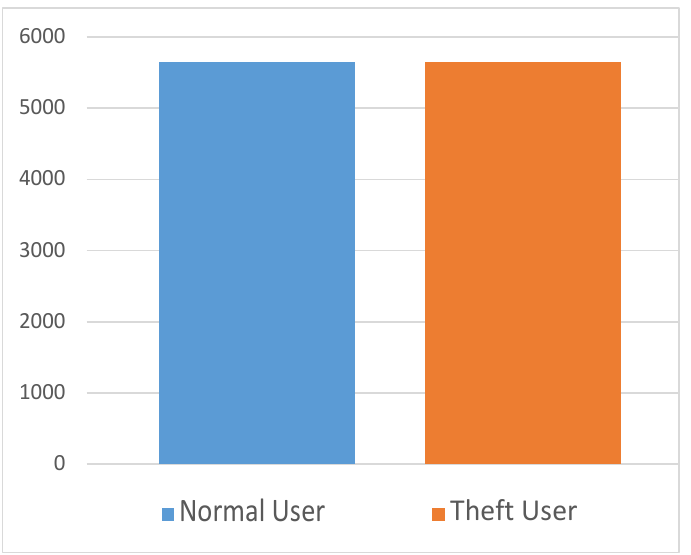
Figure 6. Smote Over Sampling Tomik Link (SOSTLink)